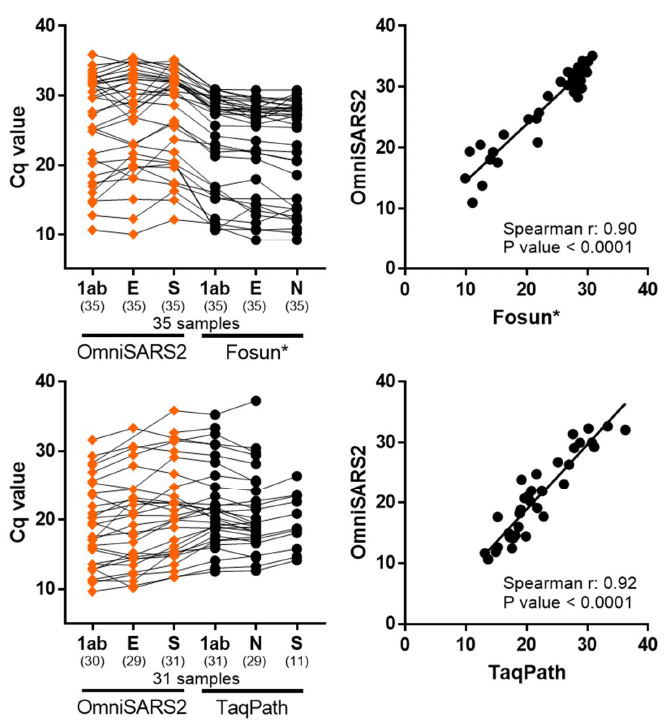
Figure 3. OmniSARS2 comparison with two commercial kits; Fosun and TaqPath. SARS-CoV-2 detection with OmniSARS2 was concordant to the Fosun and TaqPath commercial assays, correctly identifying all positive samples. Left graphs, represent clinical samples tested with the different methods. Connection lines between symbols represent matched clinical samples. The sensitivity of each of the three OmniSARS2 probes revealed high when compared with the TaqPath kit (detecting the N, Orf1ab, and S genes) which demonstrated miss-signal in 65% (detected 11 out of 31 samples) of the samples tested for the S probe. Additionally, see Supplementary Materials describing Cq values and result interpretation. Right graphs plot correlation of the 3 genes signal average between OmniSARS2 and the commercial kits. *, Fosun run method protocol set data collection and cycle record after the first 5 cycle runs, demanding interpretation caution when direct comparing the Cq values with the OmniSARS2 and TaqPath data; Cq, cycle quantification; 1ab, ORF1ab; E, envelope; N, nucleocapsid; S, spike; SARS-CoV-2, Severe Acute Respiratory Syndrome Coronavirus